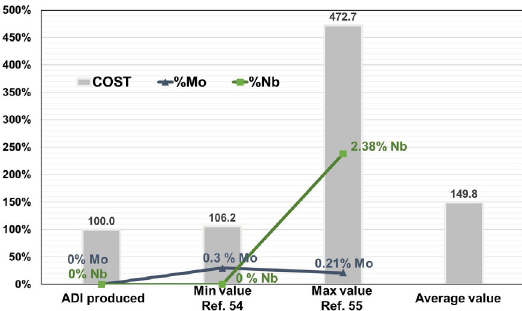
Figure 9. Cost comparison between alloys. Percentage (%) was defined as: ADI produced is 100%, and minimum and maximum values stand for the difference in relation to the ADI